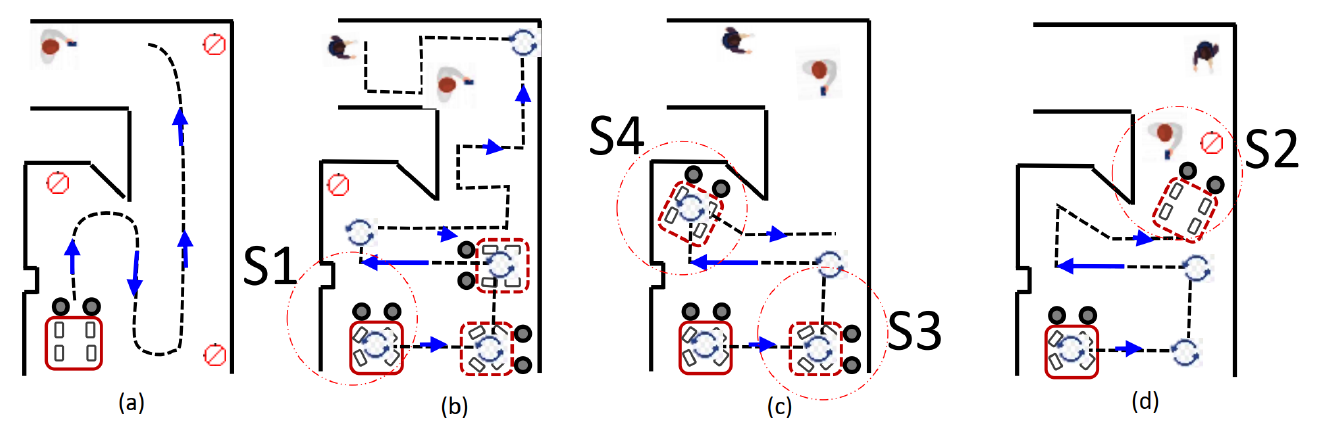
Figure 1. Scenarios for the navigation during pavement sweeping task using cleaning and mainte- nance vehicles with ( a ) turning radius, ( b ) Omnidirectional feature using independent steering action on pavement settings, ( c ) Constraints at sharp corners by the ICR selection, and ( d ) obstacle near the turning routine of the robot. S1, S2, S3, and S4 are the scenarios mentioned in Section